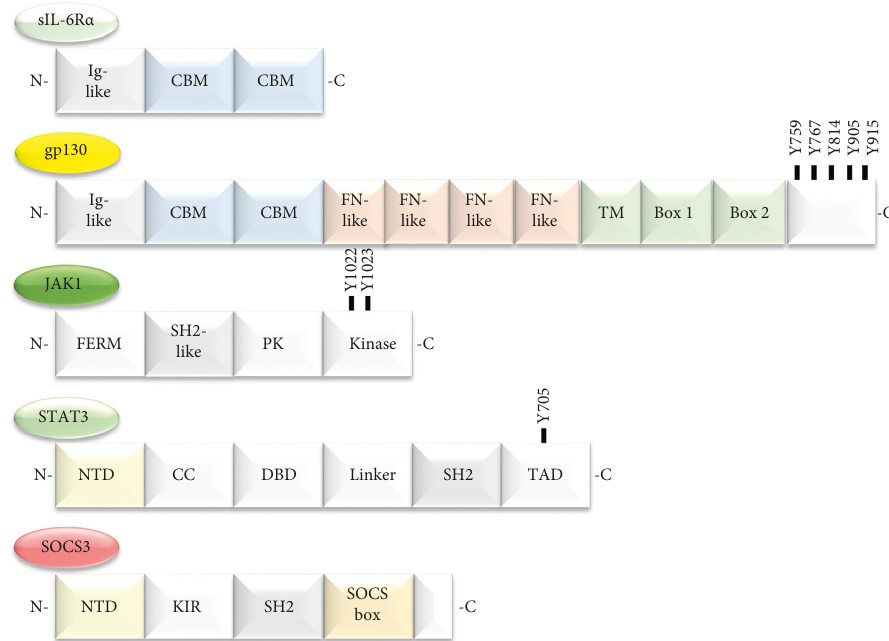
Figure 2: Protein domains in the IL-6 signalling pathway. sIL-6R α comprises an Ig-like domain and two cytokine-binding modules (CBM). gp130 also has these three domains at the N-terminus, and these are followed by four fibronectin-like domains (FN-like), a transmembrane domain (TM), and intracellular box 1 and box 2 domains required for JAK binding and signalling. JAK contains a band 4.1, ezrin, radixin, moesin domain (FERM), an SH2-like domain, a pseudokinase domain (PK), and a kinase domain. STAT3 contains an N-terminal domain (NTD), coiled coil domain (CC), a DNA-binding domain (DBD), a short linker region, and then an SH2 domain. For SOCS3, this contains an NTD, kinase inhibitory region (KIR) which inhibits JAK, SH2 domain, and SOCS box responsible for recruiting components of the E3 ubiquitin ligase complex. Key phosphorylated tyrosine residues (Y) involved in signalling protein activation are indicated.